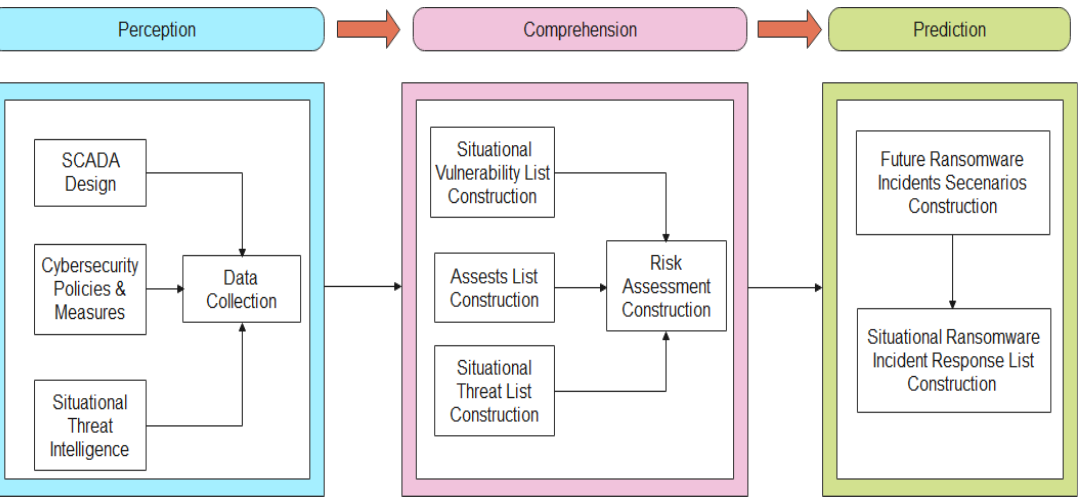
Figure 1. The proposed situational awareness ransomware incident response.